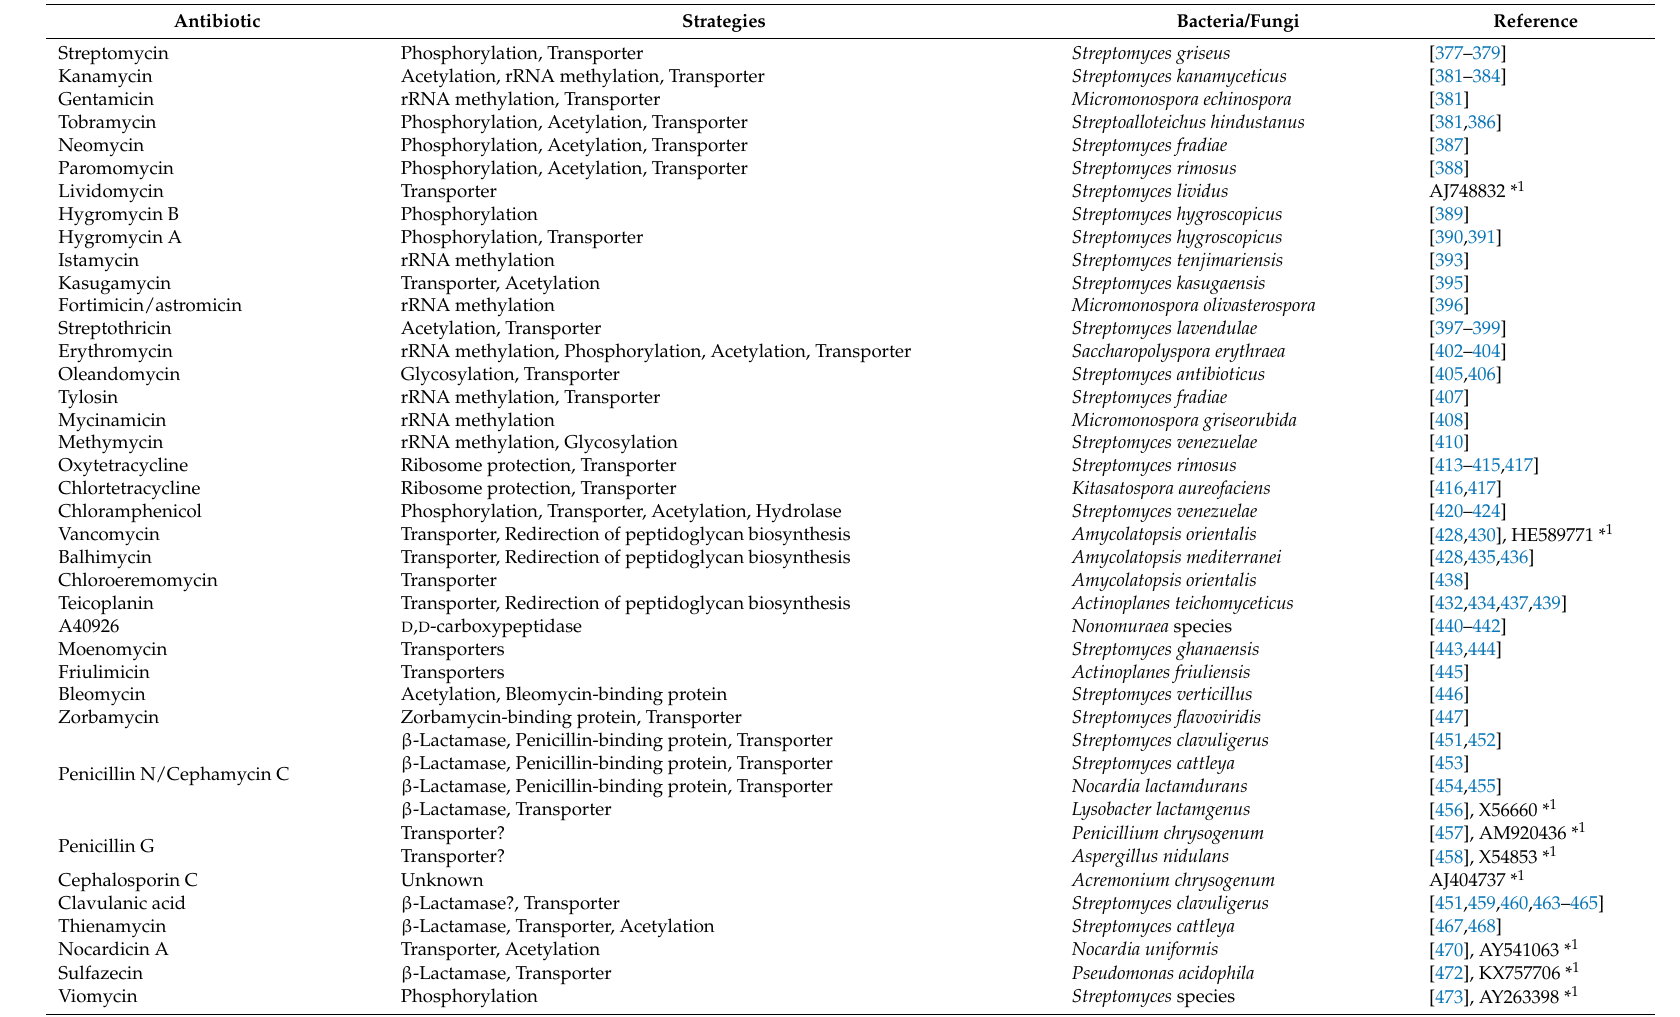
Table 5. Antibiotic resistance-related strategies in bacteria and